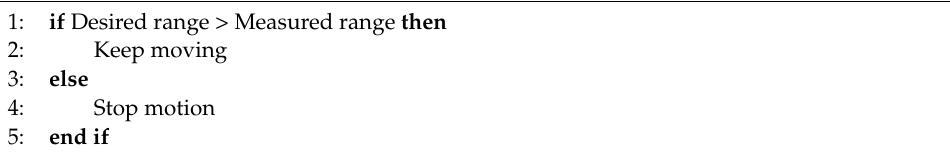
Algorithm 3 Solution 2: Conflict of Coordinates